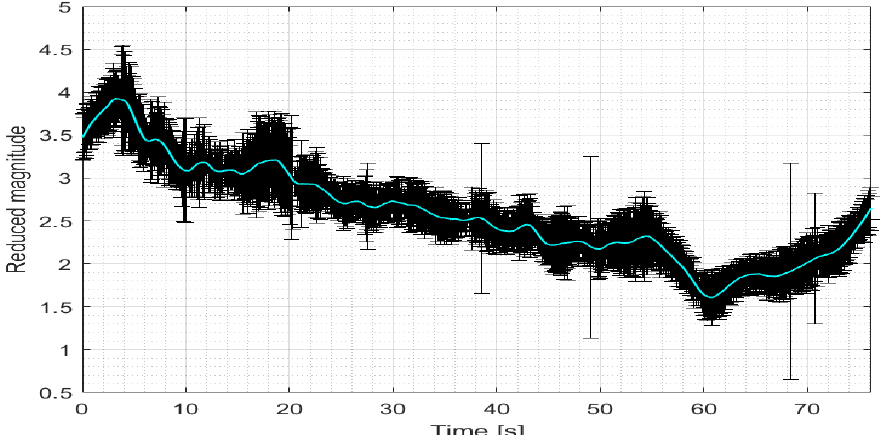
Figure 13. Observed light-curve of ATLAS 2AS CENTAUR (SSN 28096) taken the 30/10/2020 from SCUDO observatory. SCUDO